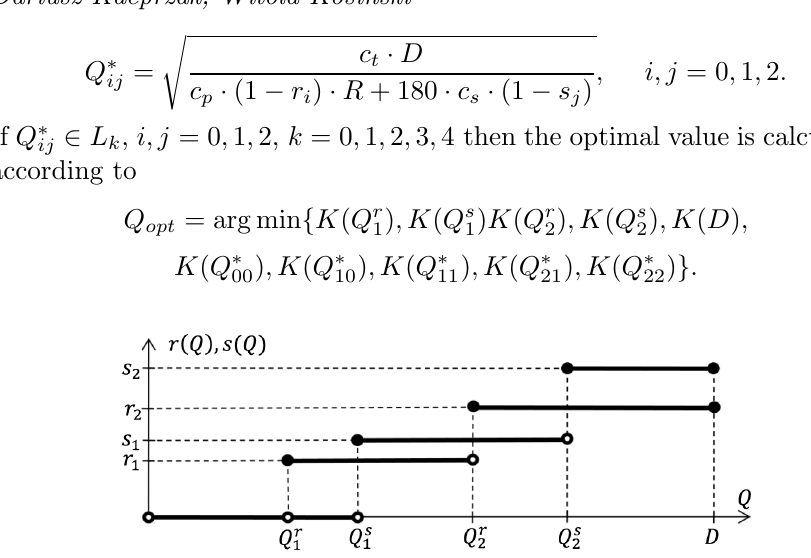
Figure 5. Step functions of the discount r ( Q ) and s ( Q